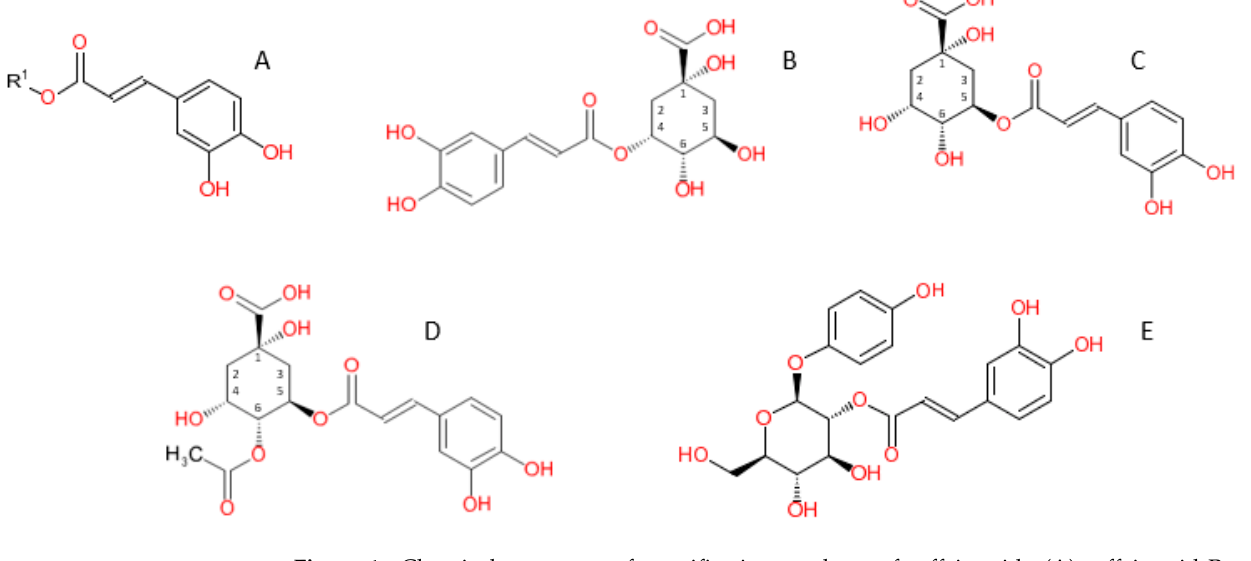
Figure 1. Chemical structures of esterification products of caffeic acid. ( A ) caffeic acid R = H, ( B ) 3- O -caffeoylquinic acid (neochlorogenic acid), ( C ) 5- O -caffeoylquinic acid (chlorogenic acid), ( D ) acetyl-caffeoylquinic acid (tentative), ( E )